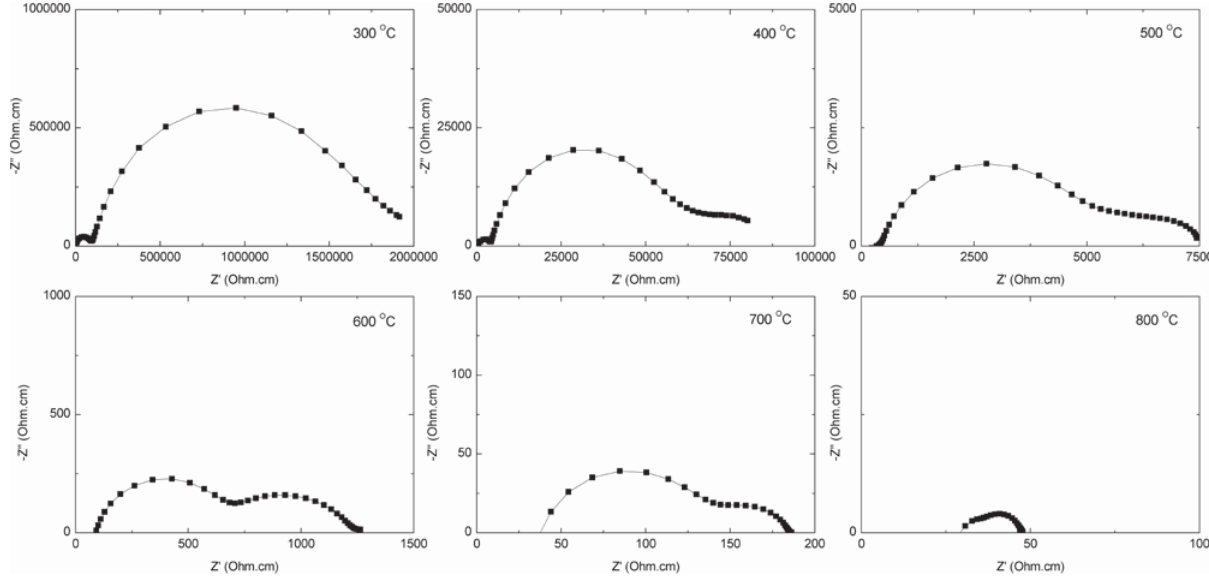
Fig. 5: The ac impedance spectroscopies of 1 wt% CuO-doped 8YSZ at different